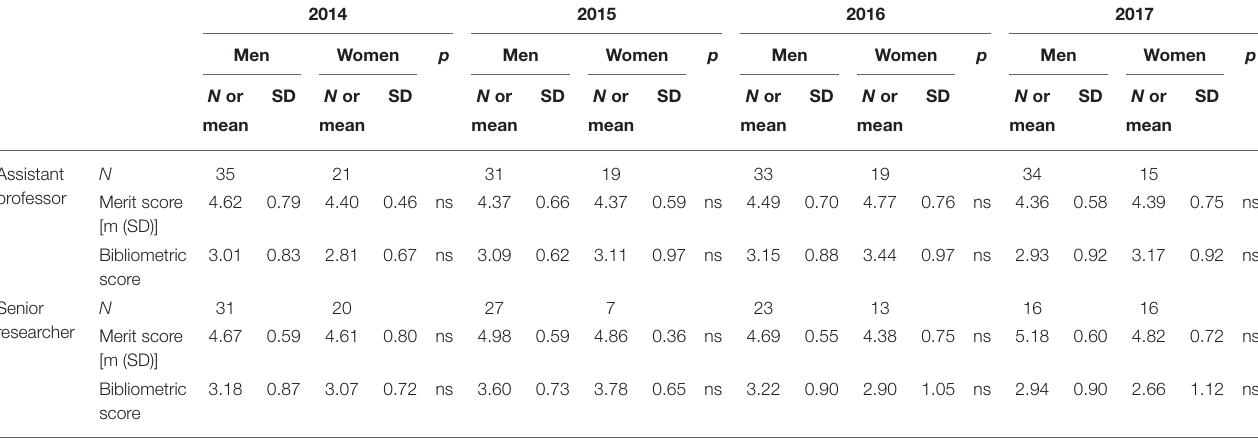
TABLE 1 | Basic characteristics of the